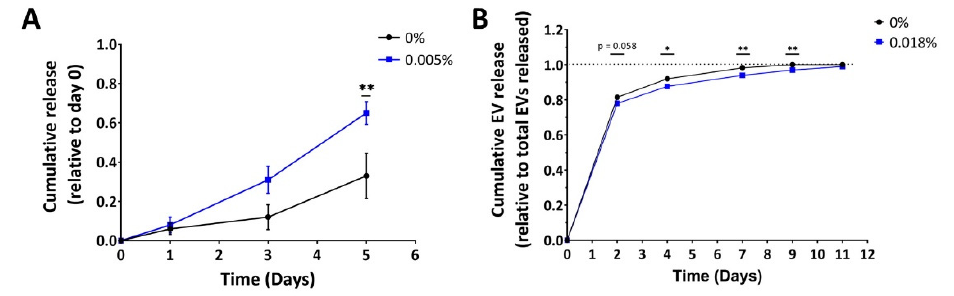
Figure 8. Alginate sulfate prolongs EV release from 3D-bioprinted alginate constructs. ( A ) Cumulative release from alginate beads (1.35% Alg) of EVs alone (blue) or incubated with alginate sulfate (0.005% w / v , 0.37% of total AlgS, purple), for the first 5 days. Each point represents the mean ± SEM cumulative release, relative to the total number of EVs on day 0. ( B ) Cumulative release from 3D printed alginate constructs (1.5% Alg, 0.36% Ca 2+ ) of EVs alone (blue) or incubated with alginate sulfate (0.018% w / v , purple), for the first 11 days post-printing, relative to the total number of EVs released. Each point represents the mean ± SEM (n = 3–4) cumulative release, * p < 0.05, ** p < 0.01, compared by two-tailed Student t-test at each time point.